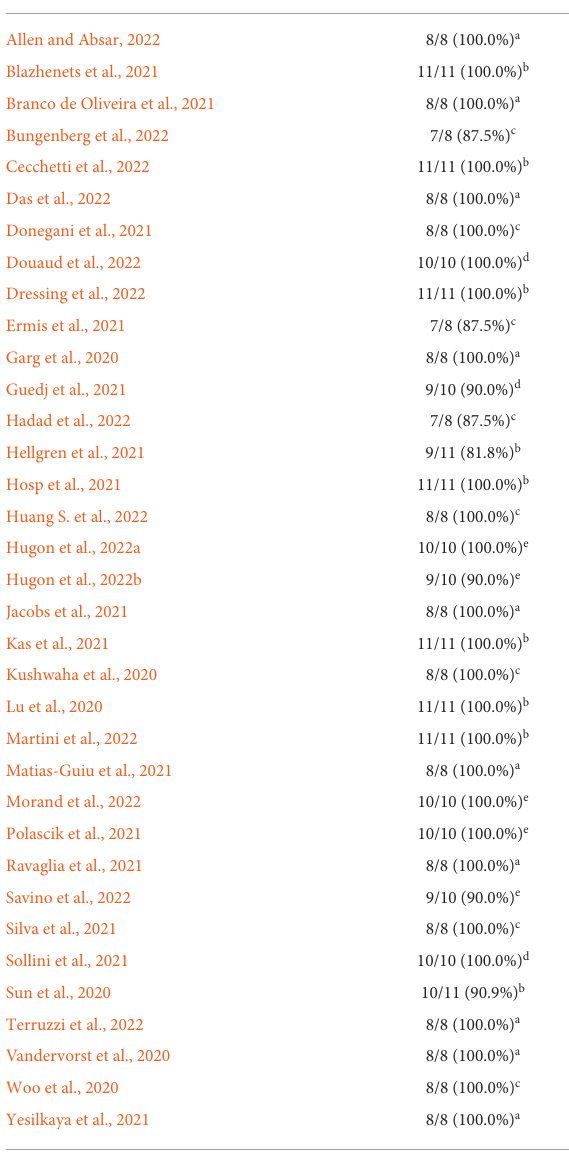
TABLE 1 Summarized quality assessment of the included